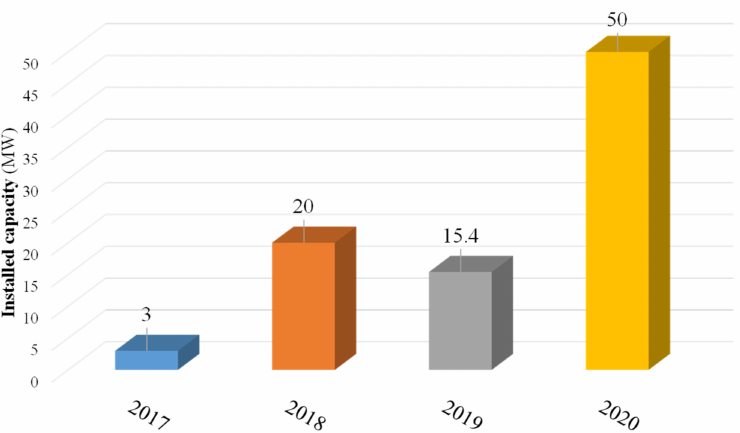
Figure 11. Historical yearly net installed capacity of solar park in Bangladesh (authors’ creation based on SREDA data